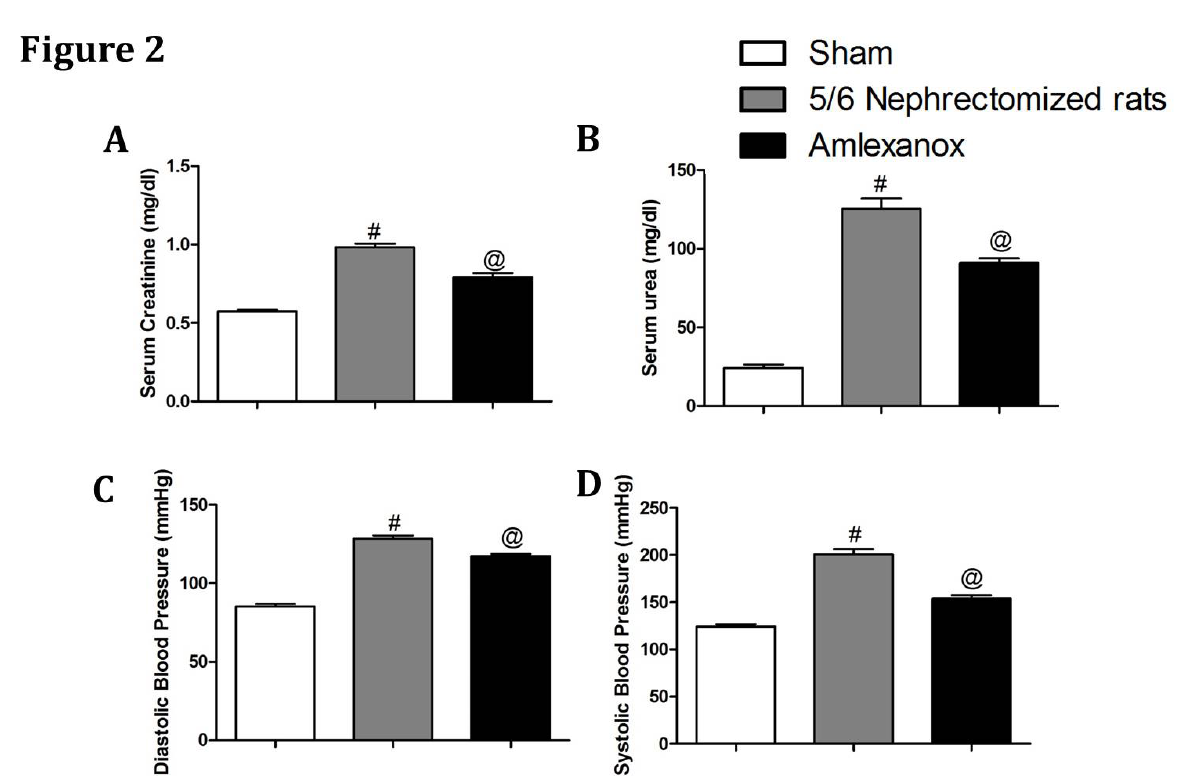
FIGURE 2 - Changes in kidney function and blood pressure 10 weeks after surgery. Quantitative analysis of serum creatinine (A) and serum urea (B) . Graphical presentation of diastolic blood pressure (C) and systolic blood pressure (D) . Amlexanox (25 mg/kg/day) was injected i.p. for 10 weeks, starting just after 5/6 nephrectomy. Groups were compared using one-way ANOVA and post-hoc Tukey’s test. Values are presented as mean ± SE (n = 6). #P < 0.05 compared with the sham group, @P < 0.05 compared with the 5/6 nephrectomy group. TABLE II - Effects on kidney functions and blood pressure after 10 days of 5/6 nephrectomy Serum Creatinine Serum Urea Diastolic blood Systolic blood (mg/dl) (mg/dl) pressure (mmHg) pressure (mmHg) Before Surgery Sham 0.55±0.01